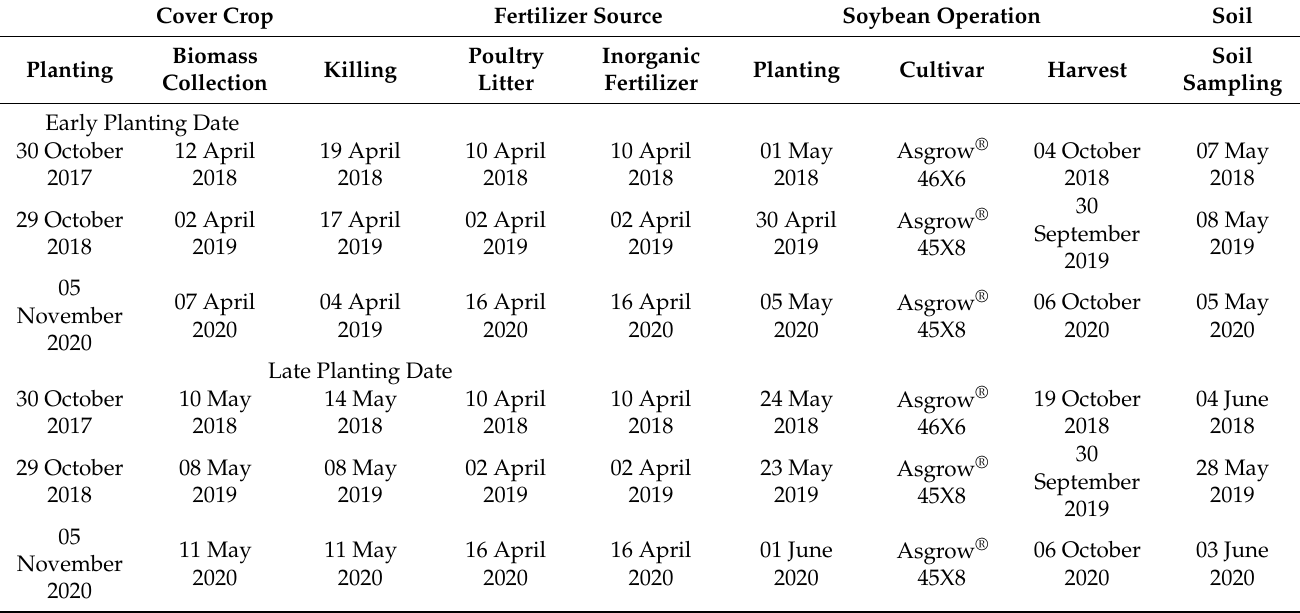
Table 2. Cover crop and soybean operation, fertilizer application and soil sampling dates from early and late planting dates in Pontotoc,